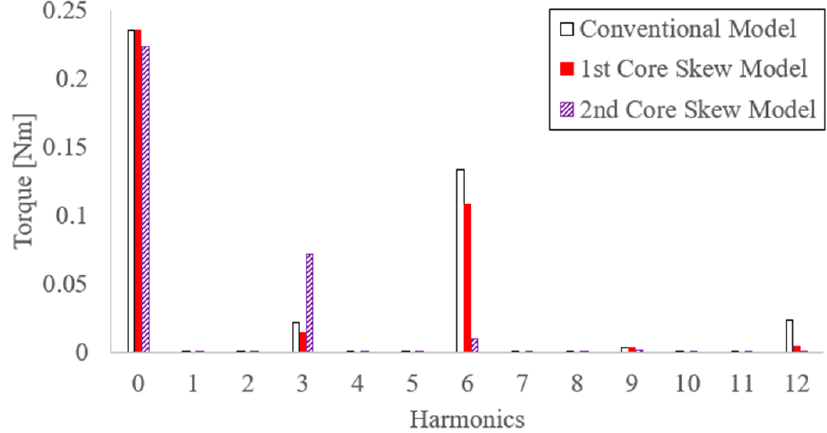
Figure 13. 15,660 rpm torque spectra.